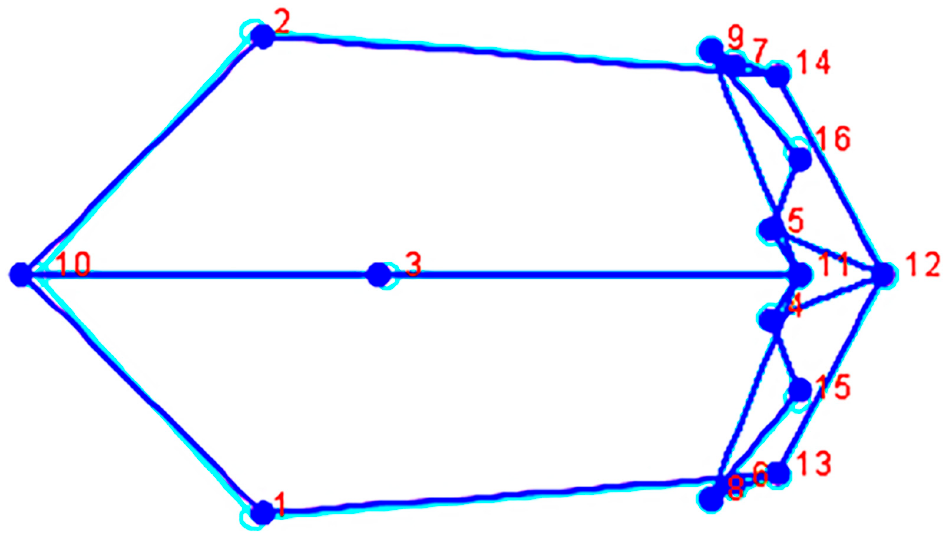
Figure 2. Wireframe (superior view) depicting the Chilean male mean configuration (starting shape, light blue) deformed into the Spanish male mean configuration (target shape, blue). The numbers correspond to the landmarks in Table 2.